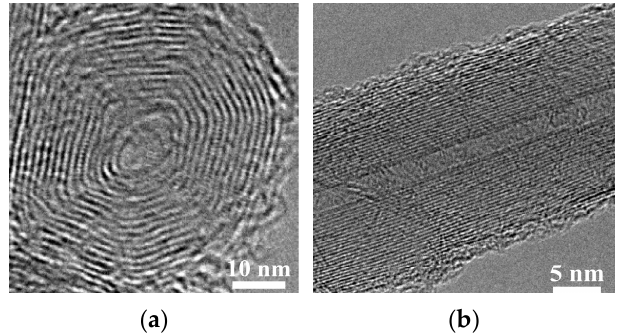
Figure 6. Typical transmission electron microscopy (TEM) images of carbon nanomaterials synthesized at z = 10 mm: ( a ) carbon nano-onion (CNO), and ( b ) carbon nanotube (CNT).